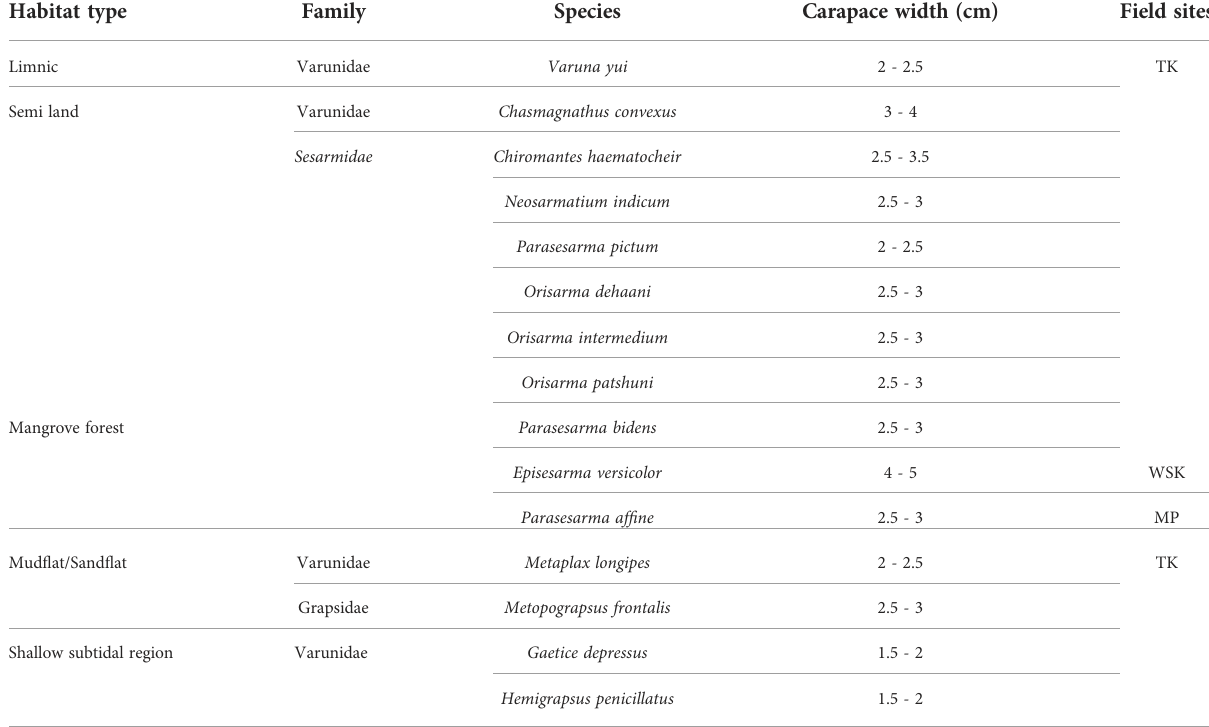
TABLE 1 List of grapsoid species by site and types of habitats collected for this study. Habitat